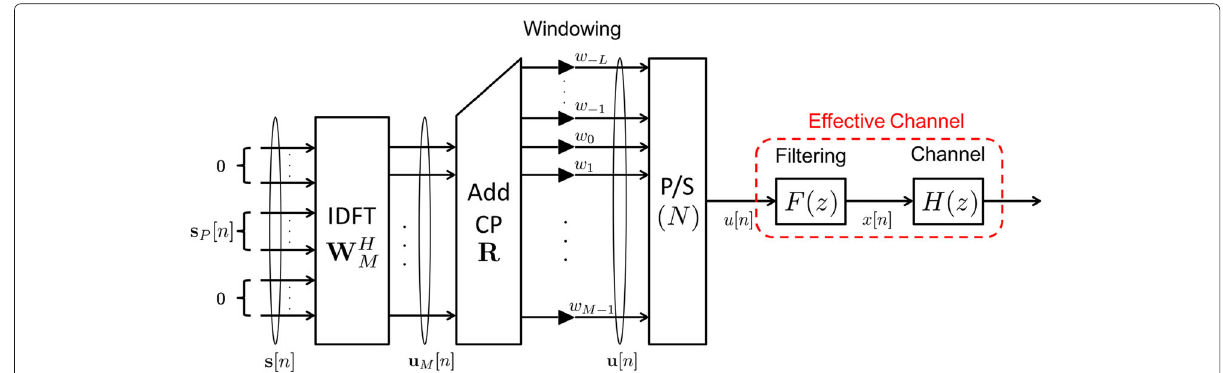
Fig. 1 Block diagram of the